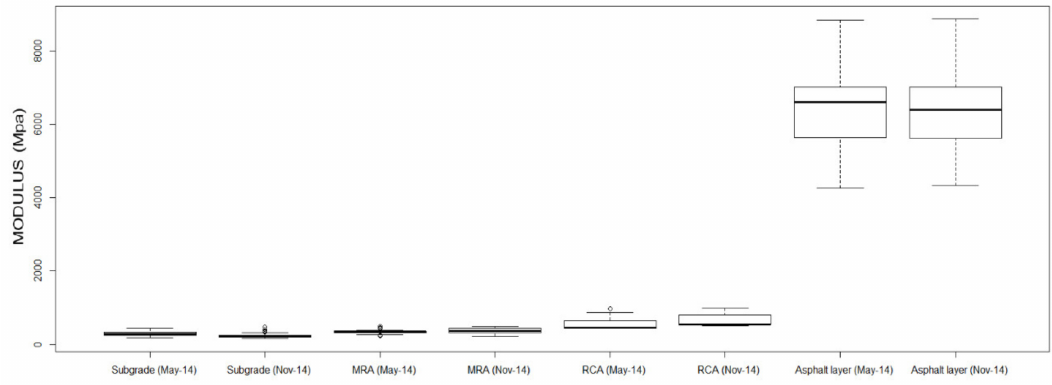
Figure 11. Boxplots showing evolution of the equivalent modulus in di ff erent layers.